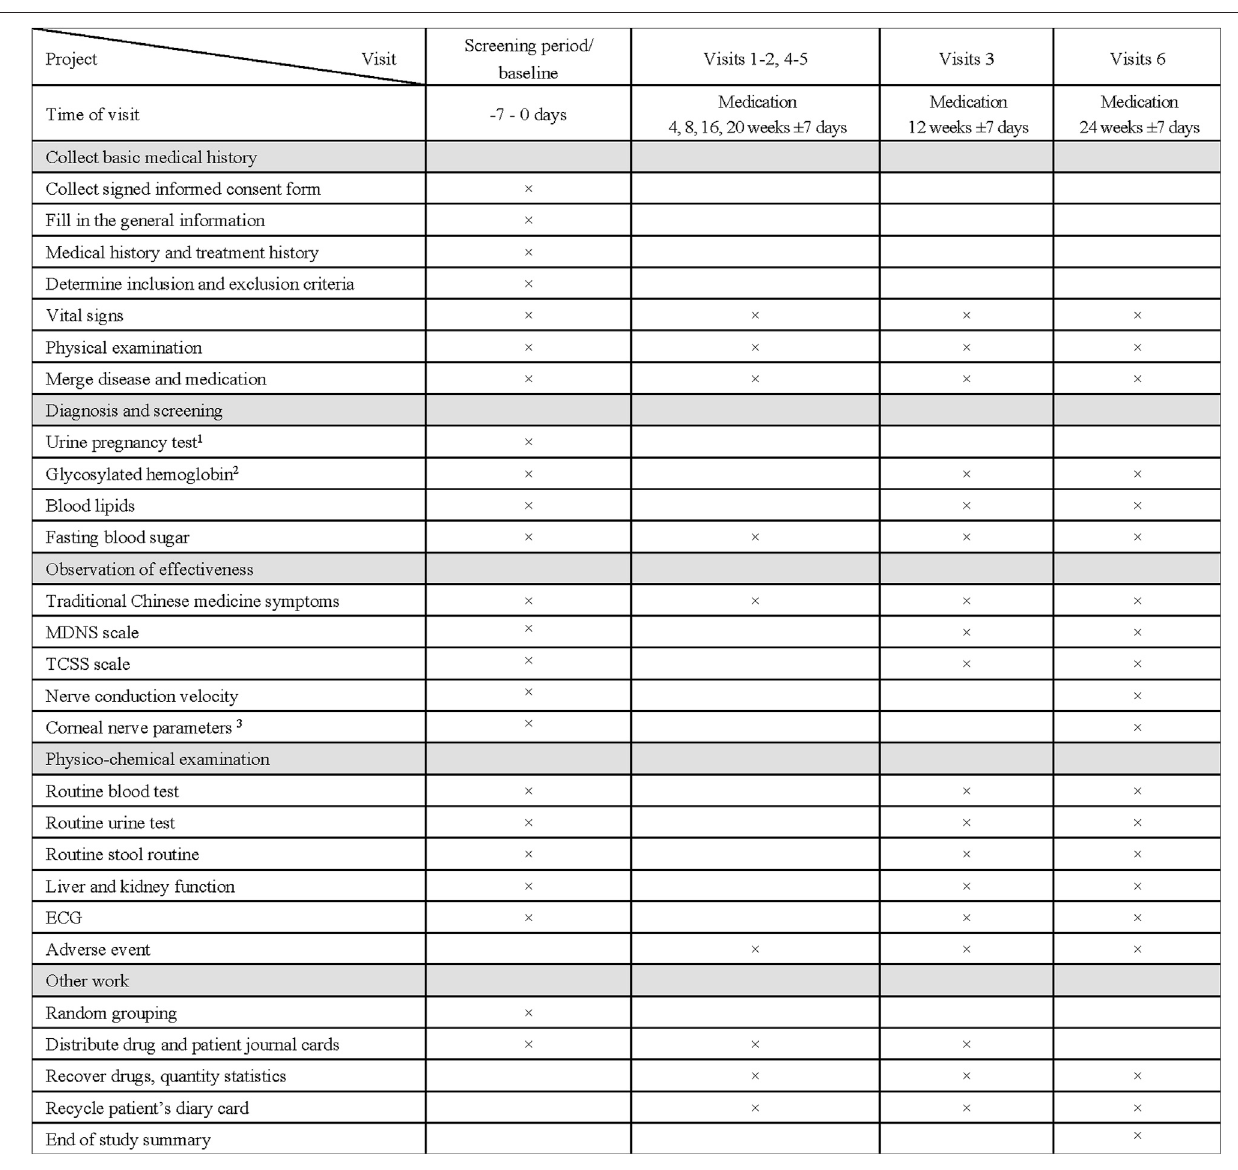
FIGURE2 | Clinical Study Visit Form. 1Only forchildbearing-age womenand secondary amenorrheawomenfor more than 1 week; Test should be initiated within 24 h prior to the fi rst medication. 2 Blood sample of the glycosylated hemoglobin will be collected and placed in – 80 ° C refrigerator. 3 Only 120 subjects in four